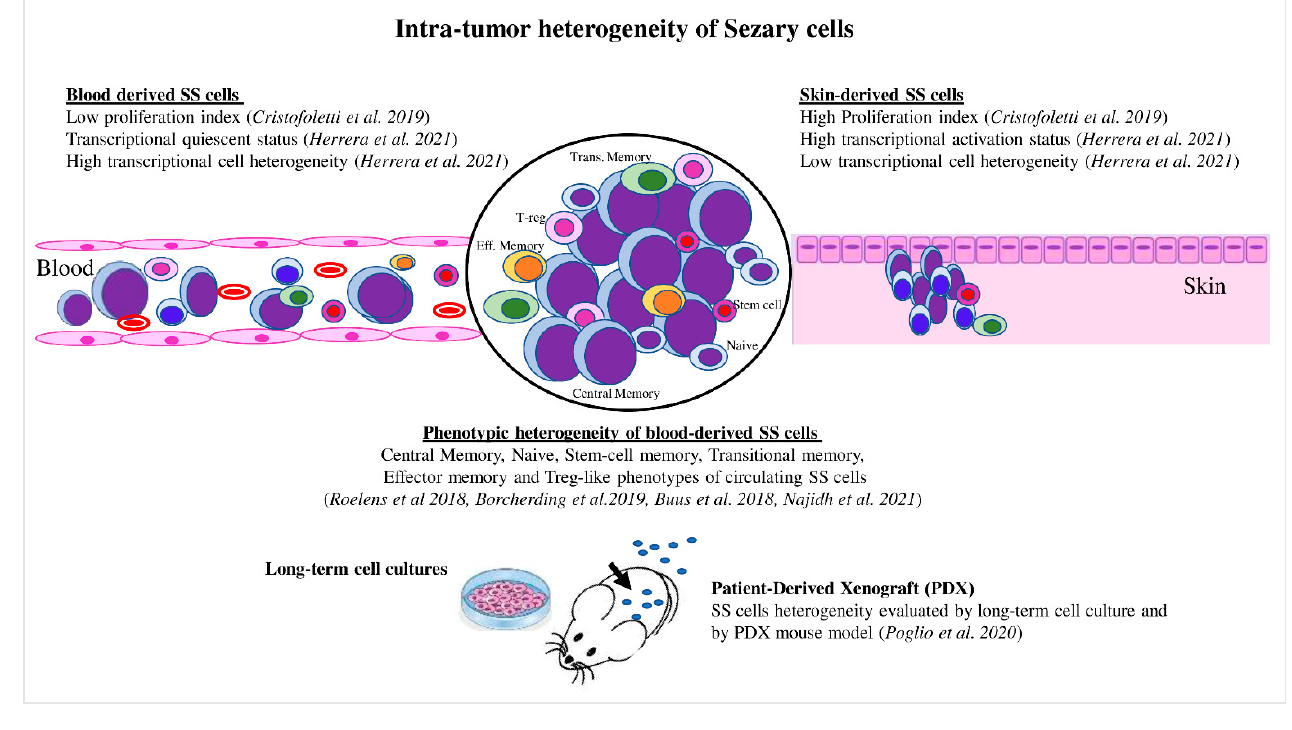
Figure 2. Intratumor heterogeneity of Sézary cells. Skin ‐ and blood ‐ derived SS cells showed dif ‐ ferences in proliferation capacity, expression of activation markers, and level of transcriptional heterogeneity. Blood SS cells showed phenotypic heterogeneity, which also was evaluated under specific culture conditions and in the PDX mouse model.